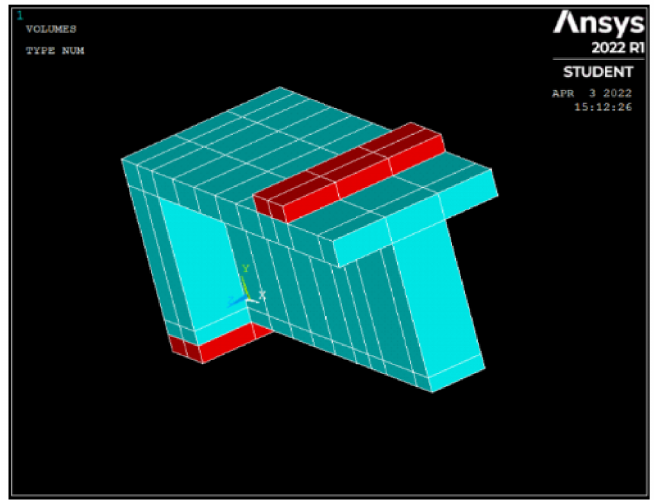
Figure 10. Three-dimensional model for specimens